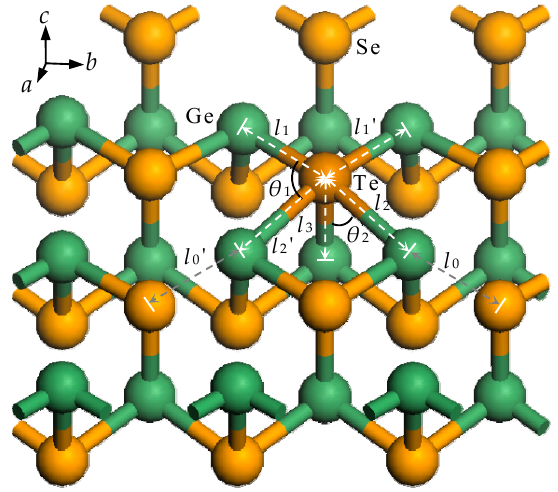
Figure 1. The perspective view of GeSe doped by a Te atom.